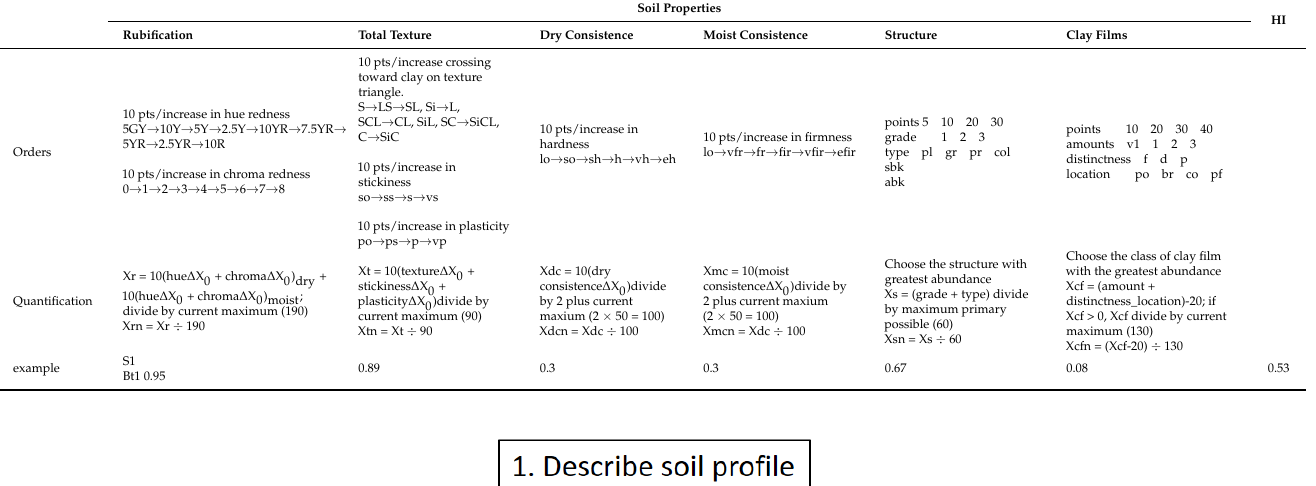
Table 2. Quantification and normalization of soil morphologies for calculating Horizon Index (HI) based on the modified guidelines of Birkeland [1] and Tsai et al. [17]. The example of the calculation is based on the soil morphologies in S1.